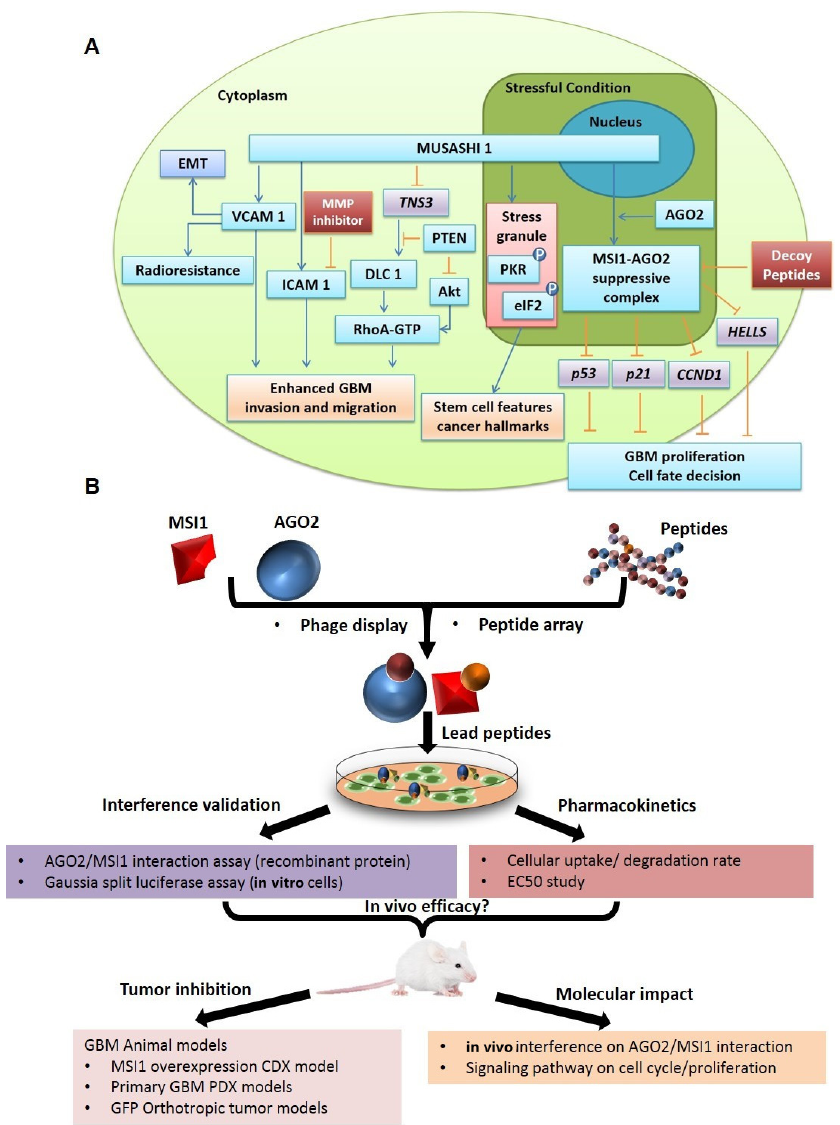
Figure 1. Functional significance of MSI1 in GBM cancer stemness and schematic workflow that illustrates the design, methodology, and key findings from the current study. ( A ) As a member of RNA-binding protein, MSI1 has been functioning to mediate cell fate decision, differentiation, maintenance of stemness for progenitor neural stem cells, and tumorigenesis for cancer cells. The roles of MSI1 have recently been explored regarding involvement in cellular EMT, radioresistance, invasion, and migration as well as downloading signaling pathways of PTEN/Akt, Notch/m- Numb, and PKR/eIF2, etc. The oncogenic formation of MSI1/AGO2 protein complex has also been implicated in promoting GBM tumor progressions. ( B ) The workflow that had been conducted for discovery of unknown peptides that could specifically interfere with MSI1 interaction with AGO2. Key experimental designs utilized for validations of identified peptides are also